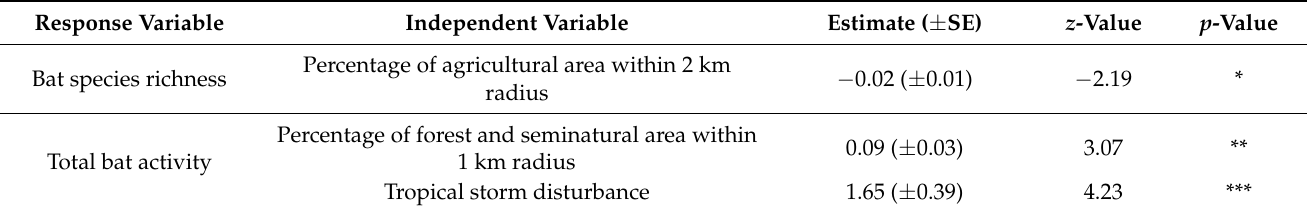
Table 4. Results of statistical analyses showing the effects of landscape characteristics on bat species richness, total bat activity, total number of feeding buzzes, activity of each bat species, and activity of each foraging